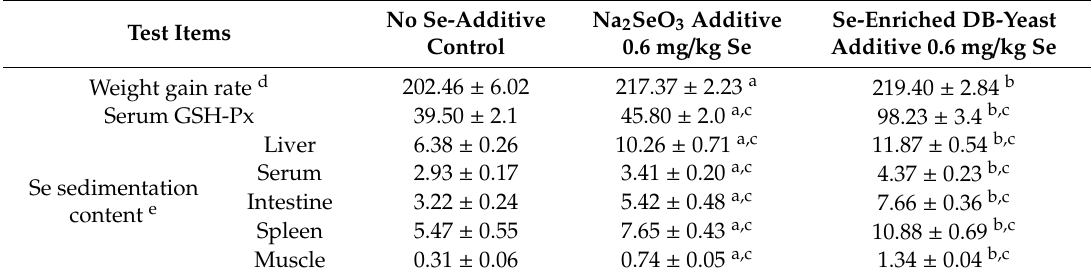
Table 5. E ff ects of the Se source on genetically improved farmed tilapia ( Oreochromis niloticus ) (GIFT) growth after 60 days of